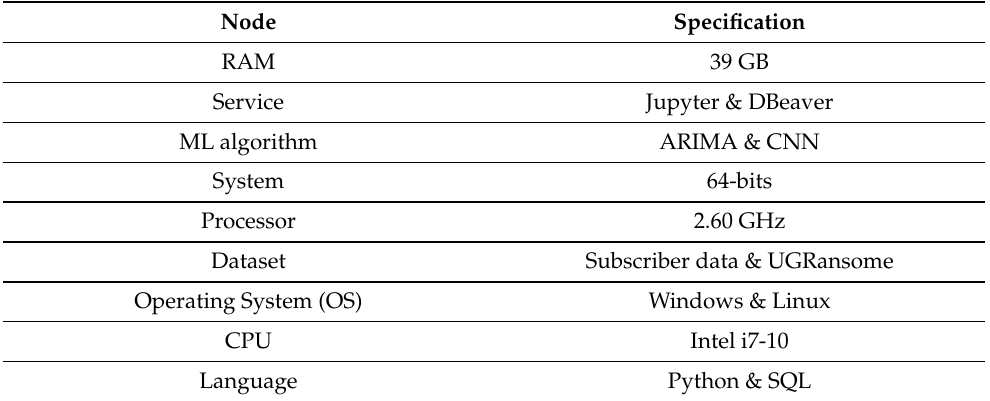
Table 4. Framework